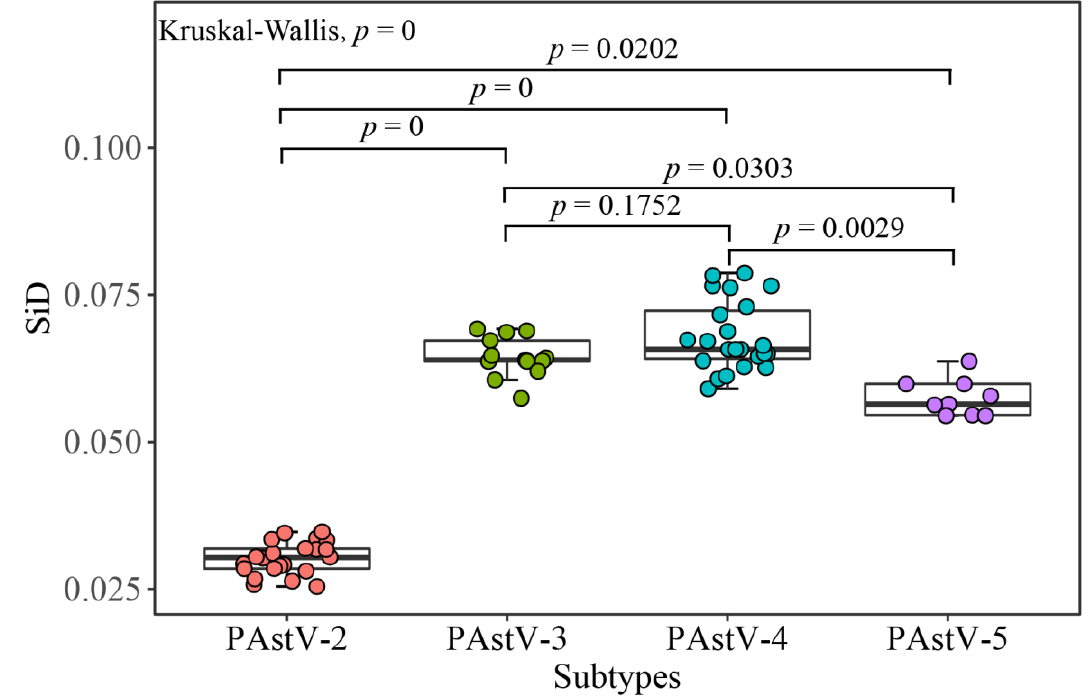
Figure 9. Similarity index (SiD) of the PAstV complete coding genomes. PAstV-2, PAstV-3, PAstV-4, and PAstV-5 strains are represented in orange, green, blue, and purple, respectively.